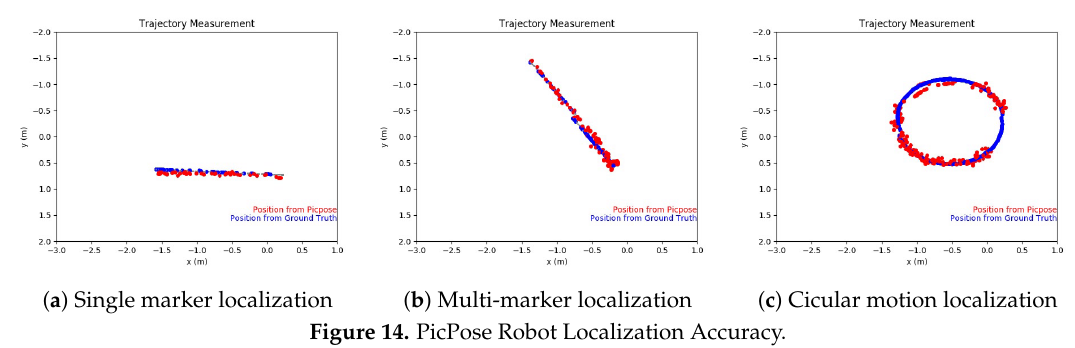
Figure 14. PicPose Robot Localization Accuracy.